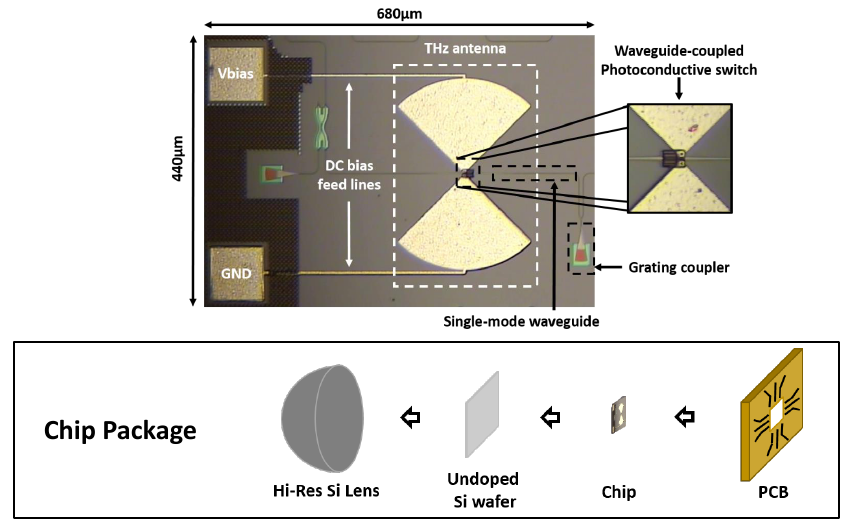
Figure 5. Micrograph of the prototype THz impulse radiator chip and chip